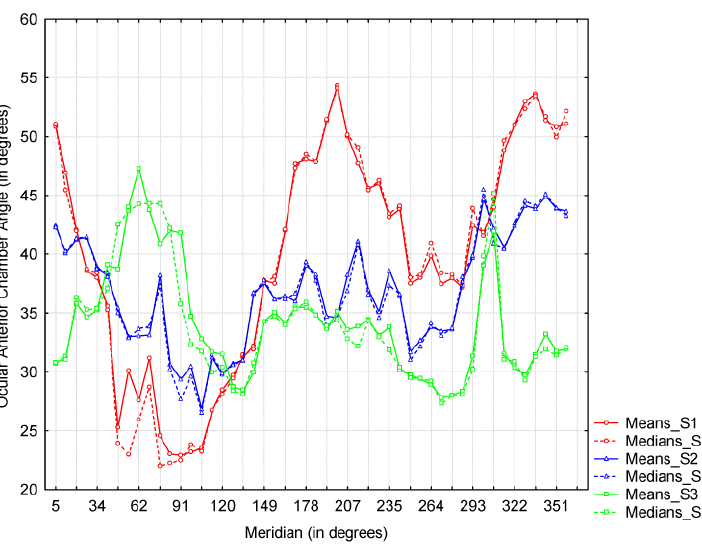
Figure 2. Variation in the means and medians for ACA for dif- ferent meridians of three young female eyes are indicated. For each eye, and subject, solid or dashed coloured curves represent the means and medians respectively. Results for Subject 1 are in red, Subject 2 in blue and Subject 3 in green. Possible outliers in Subjects 1 and 3 (near meridian 60 0 ) result in the means and me- dians becoming a little different and the solid and dashed lines are seen to depart from one another but mostly within specific meridians the intra-subjective means and medians are similar. Table 1 . Means and standard deviations for meridians 5 to 358 0 are provided for the ocular anterior chamber angle for the right eyes of three young female subjects, all aged 22 years. (Each of the means in columns two to four is the average of 10 measure- ments as obtained using the Oculus Pentacam.) The units are degrees throughout and the usual mathematical convention ap- plies (that is, angles are measured counter-clockwise from the horizontal meridian). Thus the superior-nasal quadrant of the right eye would be represented by meridians 5 to 84 0 . Since Fig- ure 1 suggests for the different subjects that for most meridians the means and medians were similar, the parametric means are provided here rather than the